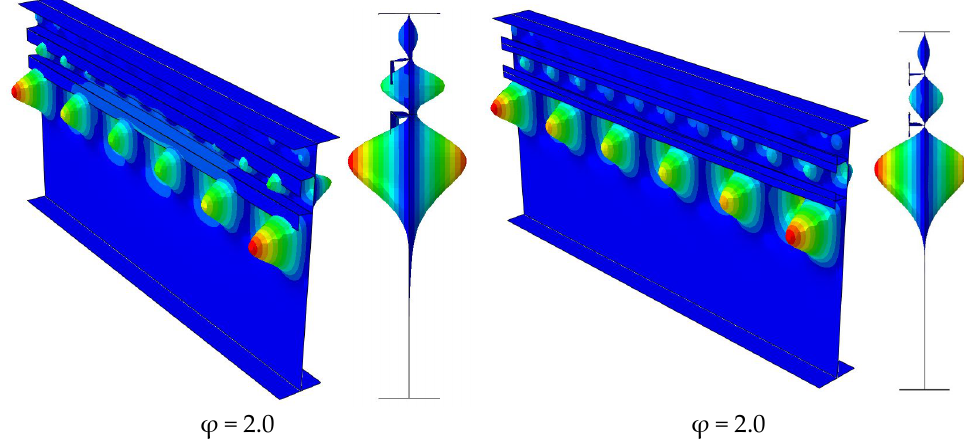
Figure 6. Buckling mode shapes of the stiffened girder with T-shaped and L-shaped stiffeners.